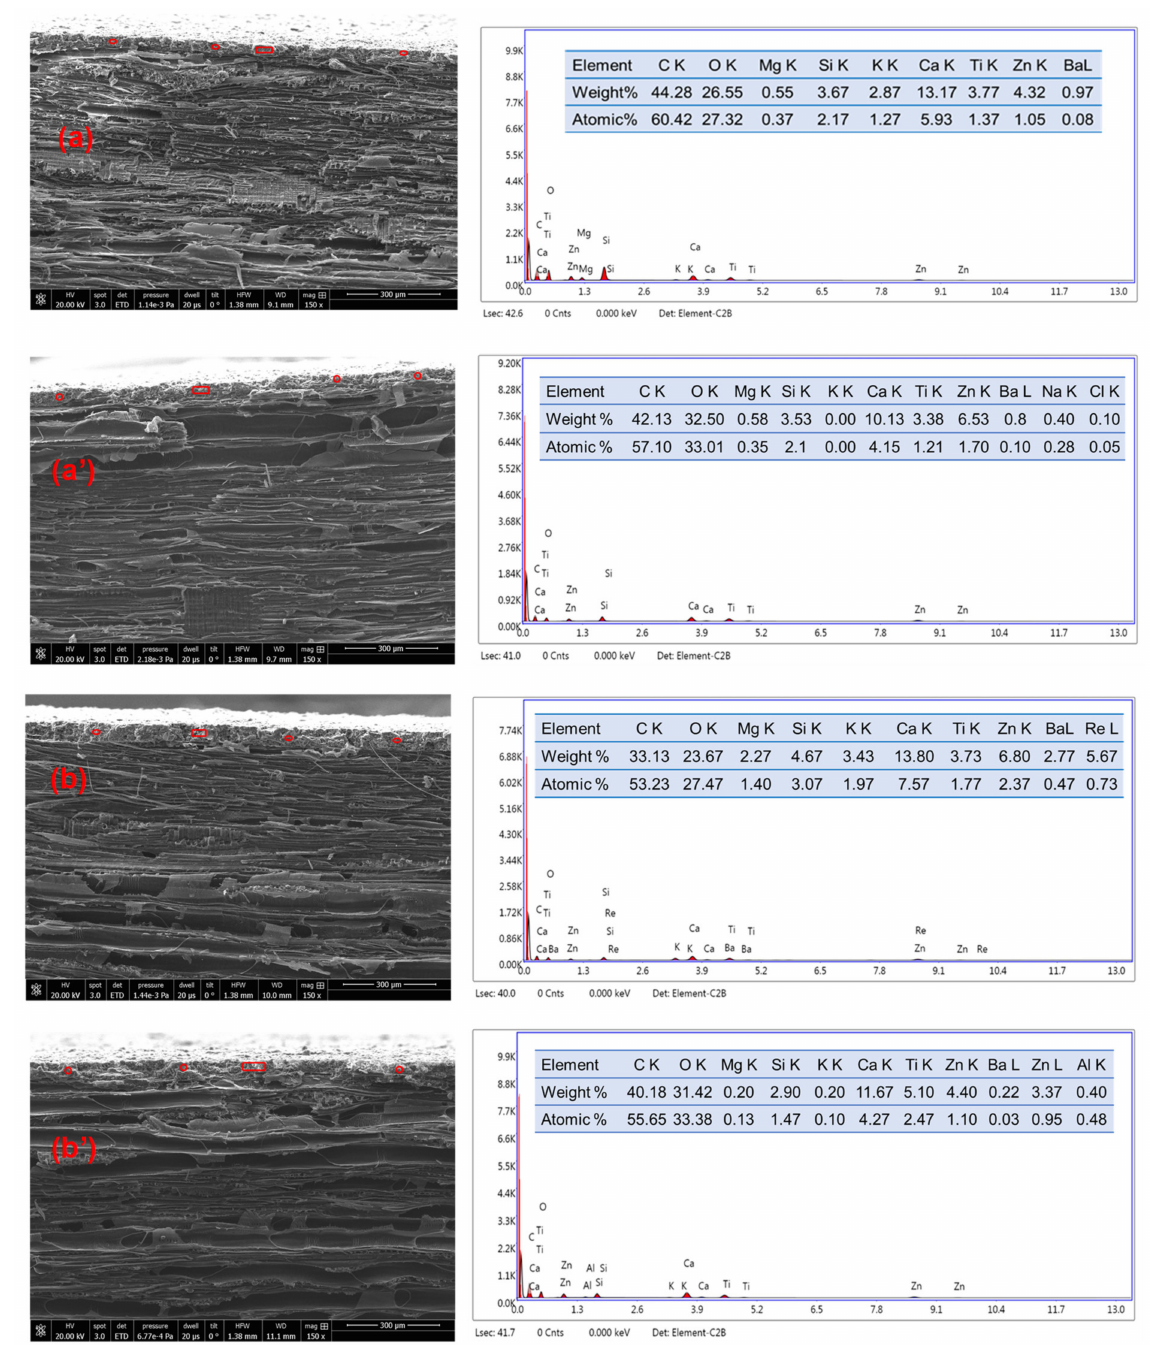
Figure 12. EDX analyses of the coatings SW1 ( a , a’ ) and SW2 ( b , b’ ) before ( a , b ) and after ( a’ , b’ ) water exposure. Analyses were performed at different area of the fractured surfaces following to the